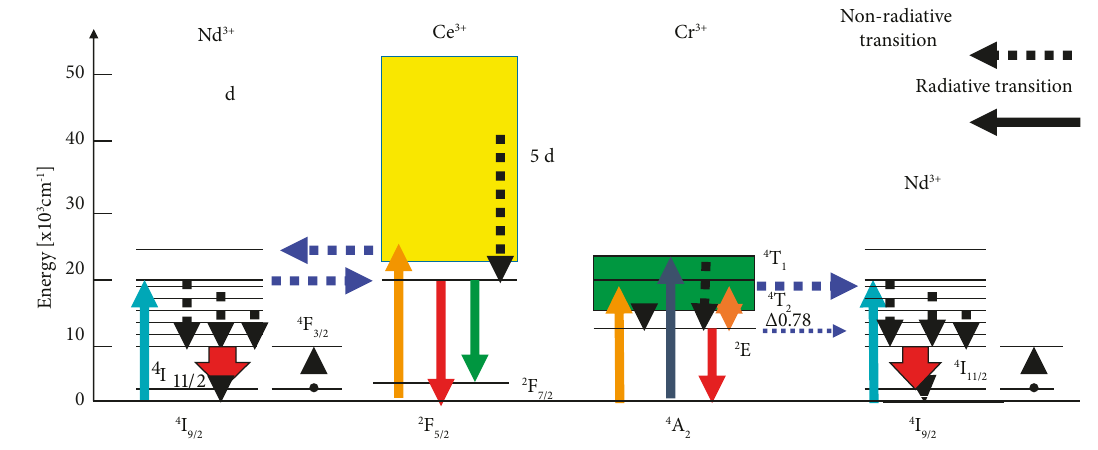
Figure 1: Energy diagram of Ce/Cr/Nd :YAG ceramic